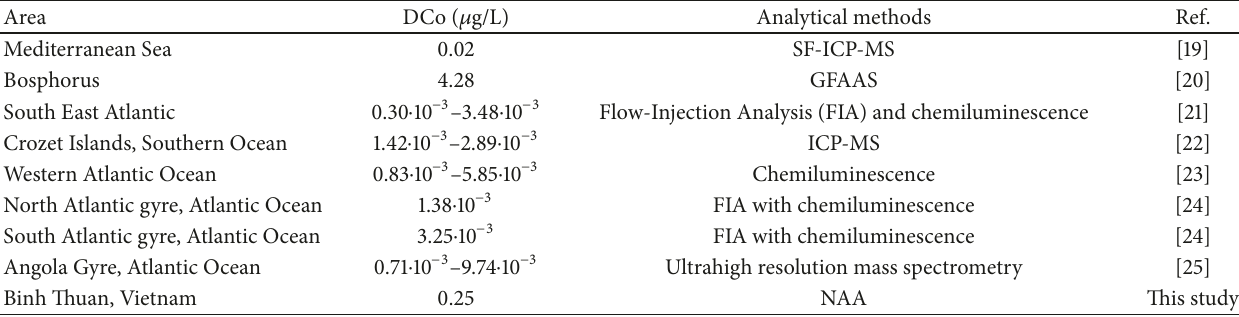
Table 5: Content of cobalt in the seawater at some areas in the world obtained within the same and/or different analytical methods. Here GFAAS and SF-ICP-MS stand for graphite furnace atomic absorption and sector field inductively coupled plasma mass spectrometers,